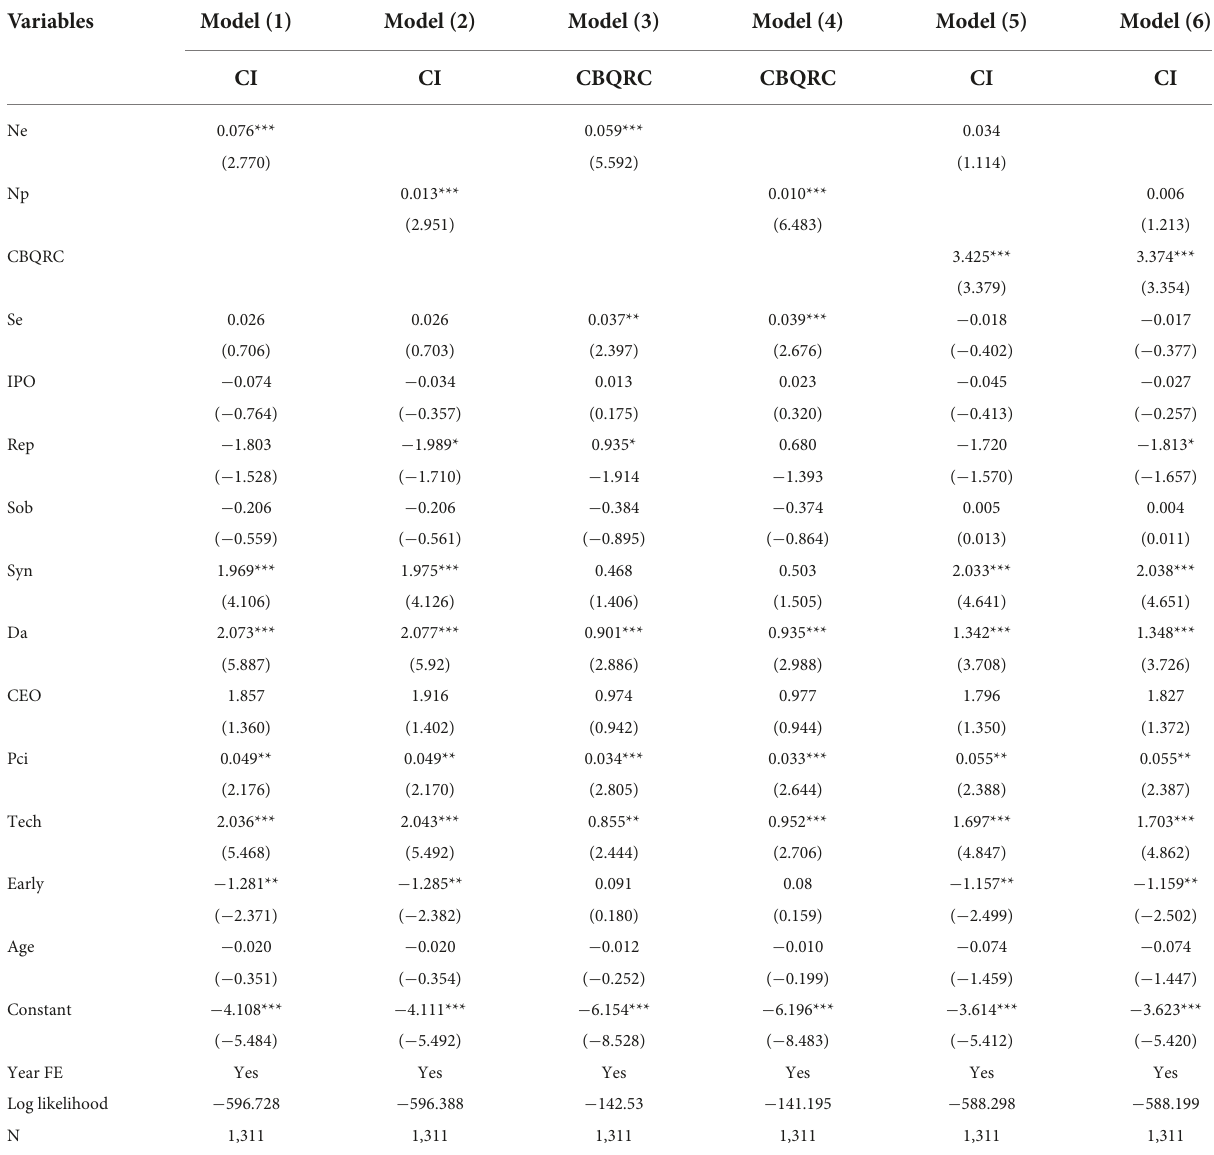
TABLE 3 Baseline regression